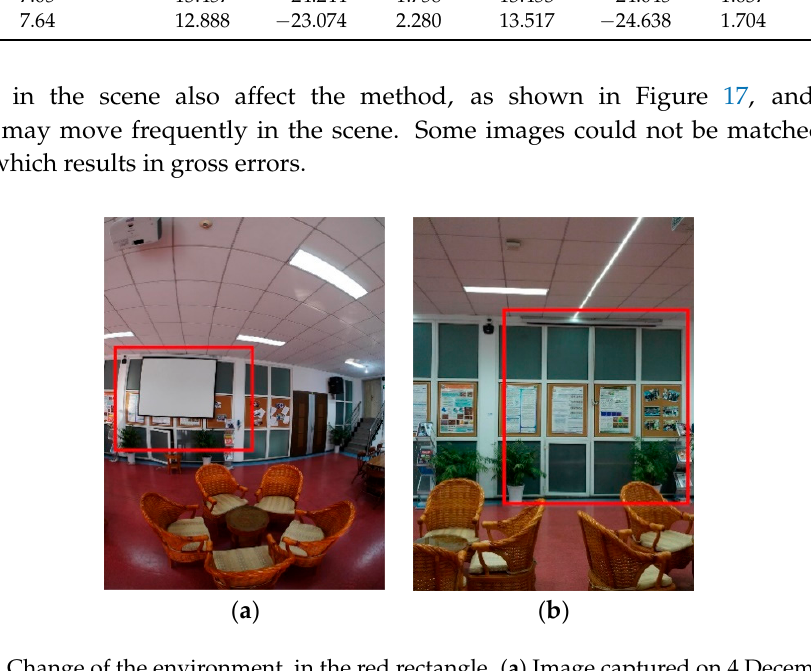
Table 8. Computational time of each procedure.